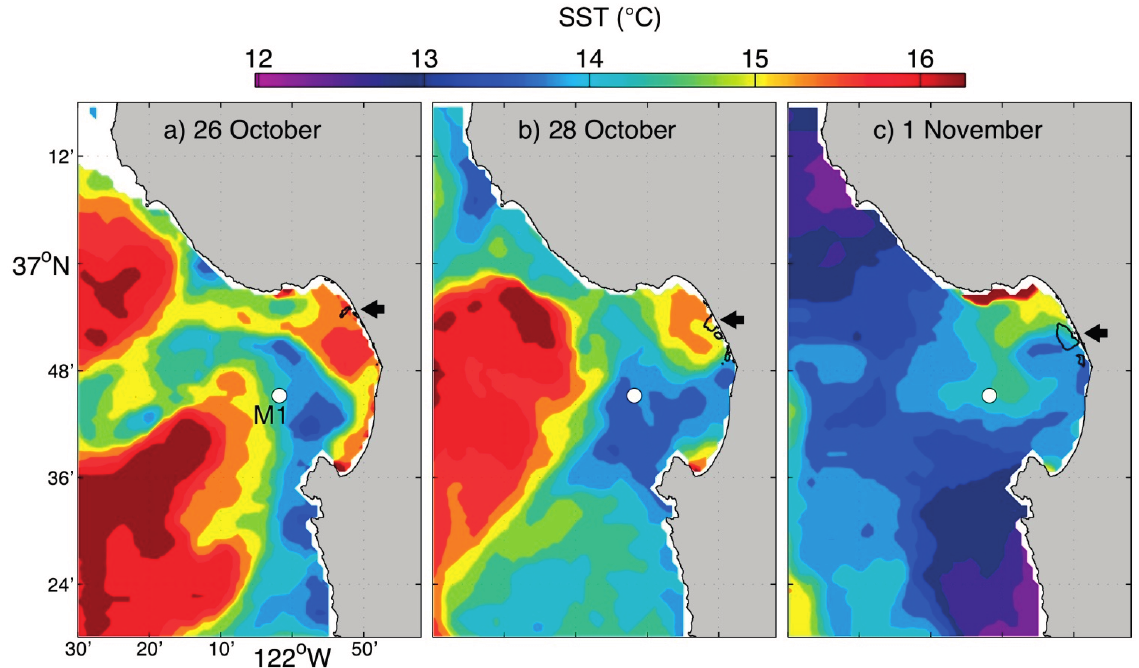
Figure 10. Fall 2011 study: Processes of bloom growth. Black contours overlaid on the SST images (indicated by arrows) correspond with the red tide bloom patches shown in Figure